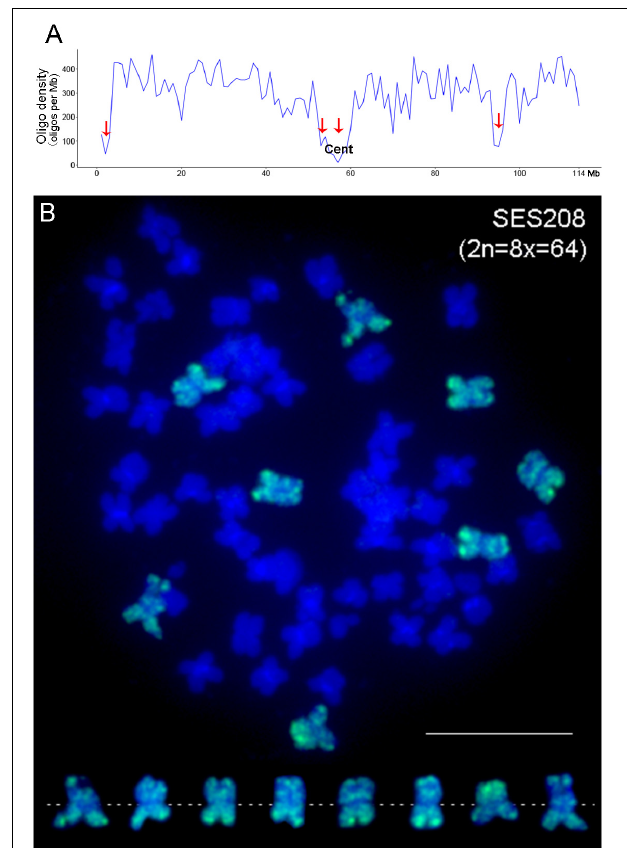
FIGURE 1 | Development of oligo-based CP2 probe in S. spontaneum . (A) The distribution of oligos on chromosome 2. The x - and y -axis indicate the position on chromosome 2 and the oligo density (oligo numbers per megabase window), respectively. The red arrows indicate the genomic regions containing a low density of oligos. (B) FISH mapping of the CP2 probe in S. spontaneum SES208 (2n = 8x = 64). The eight copies of chromosome 2 were digitally excised from the same cell and are shown in the bottom. Scale bar, 10 µ